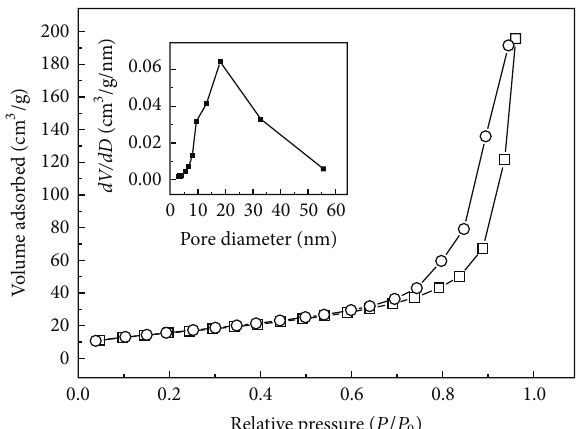
Figure 3: Nitrogen adsorption-desorption isotherm with its cor- responding pore size distribution in the inset of the Zn-doped SnO 2 /Zn 2 SnO 4